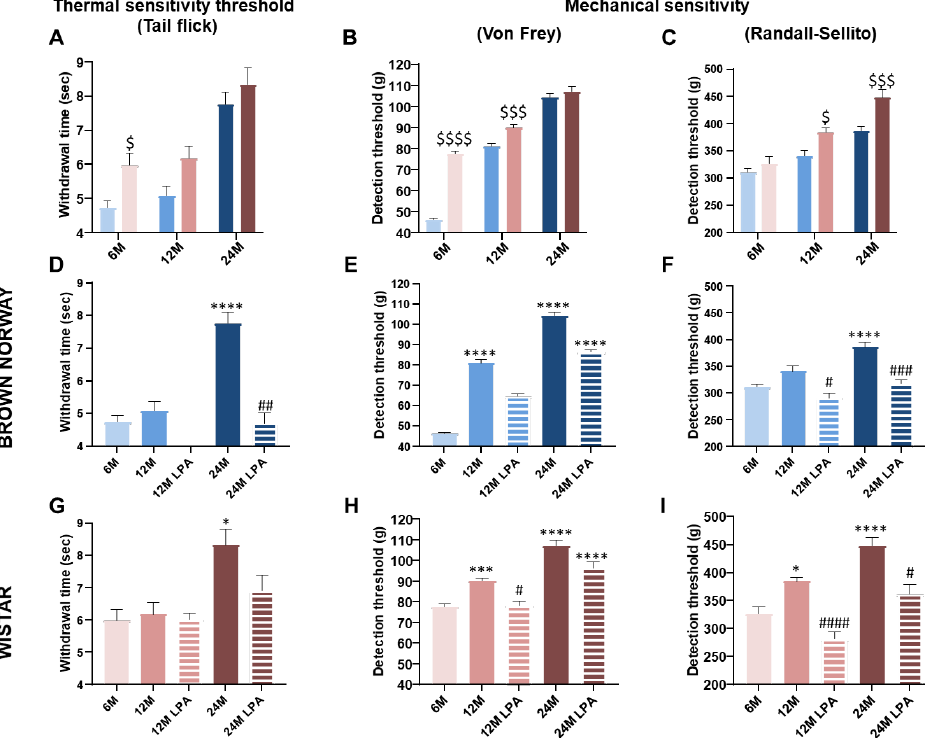
Figure 5. Evolution of the thermal and mechanical skin sensitivity over time with (hatched bars) or without (solid bars) LPA treatment. Thermal sensitivity was assessed using the tail flick test ( A , D , G ) and mechanical sensitivity with Von Frey ( B , E , H ) and Randall–Selitto ( C , F , I ) tests. The results were obtained for both BN (in blue) and Wistar (in pink) strains for 6 month old (6 M), 12 month old (12 M), and 24 month old (24 M) rats previously fed a diet supplemented with α -lipoic acid (0.5%) for 4 weeks (LPA) or not. Error bars represent the standard error of the mean. Statistical analyses were performed revealing significant differences between the two strains for each age group ($ p < 0.05; $$$ p < 0.001; $$$$ p < 0.0001 vs. BN strain) or during skin aging when compared to the 6 month condition (* p < 0.05; *** p < 0.001; **** p < 0.0001) and after LPA treatment compared to age-matched untreated condition (# p < 0.05; ## p < 0.01; ### p < 0.001; #### p < 0.0001).